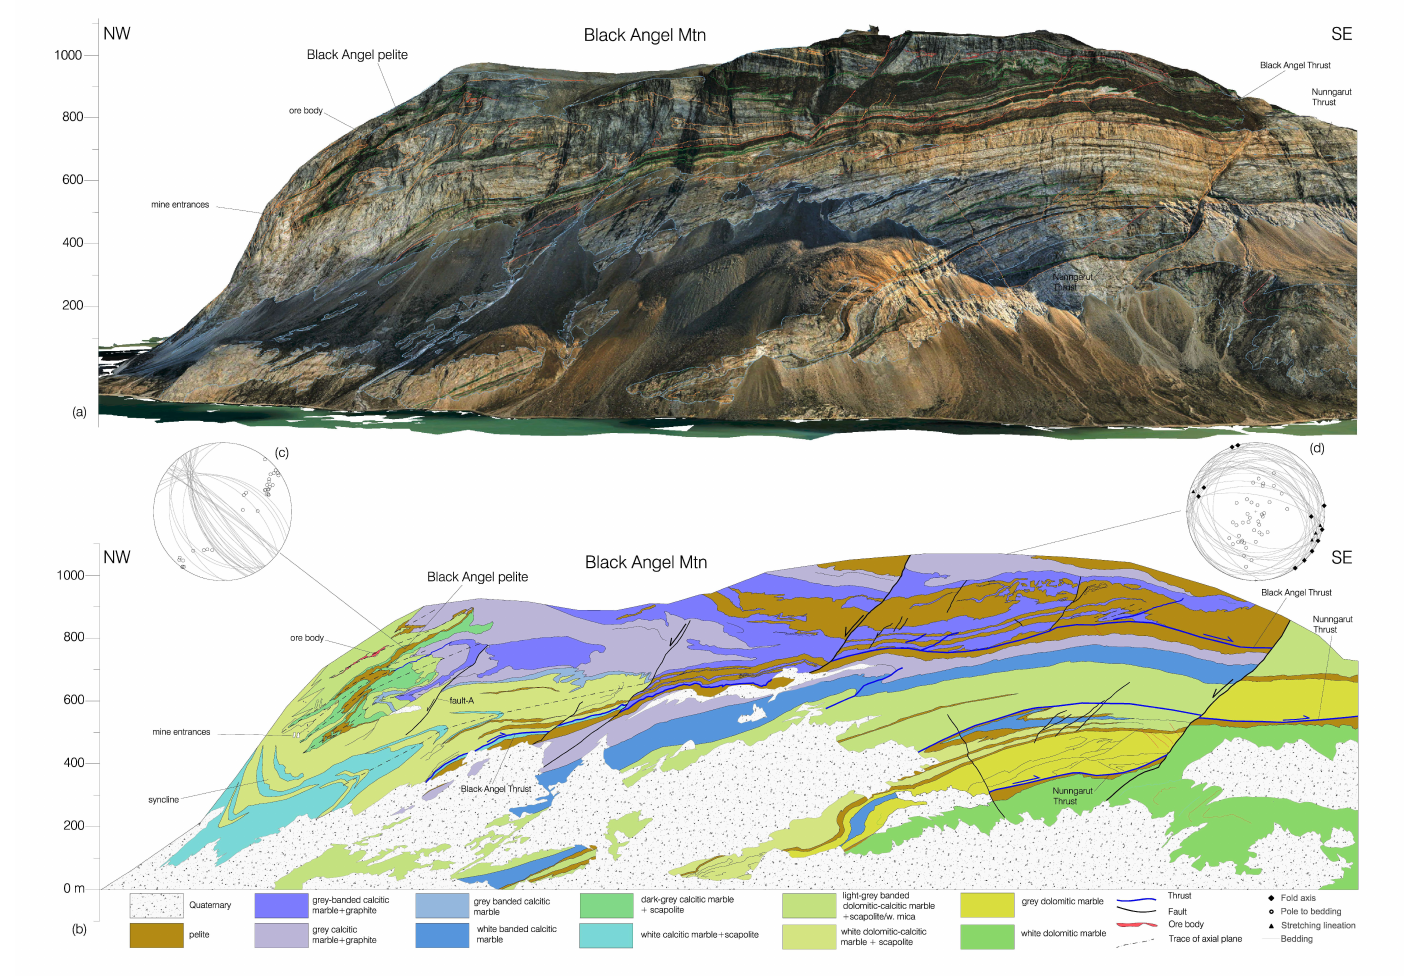
Figure 7. Comparison between Virtual Outcrop Model ( a ) and the geological map of the Black Angel cliff ( b ) obtained from the integrated stratigraphy and showing major structures mapped from 3D-photogeology and different mineral composition of the marbles (see legend in Figure 5). ( c ) lower hemisphere stereoplot of planar fabric from 3D-photogeology and ( d ) planar and linear fabric collected in the field (modified after